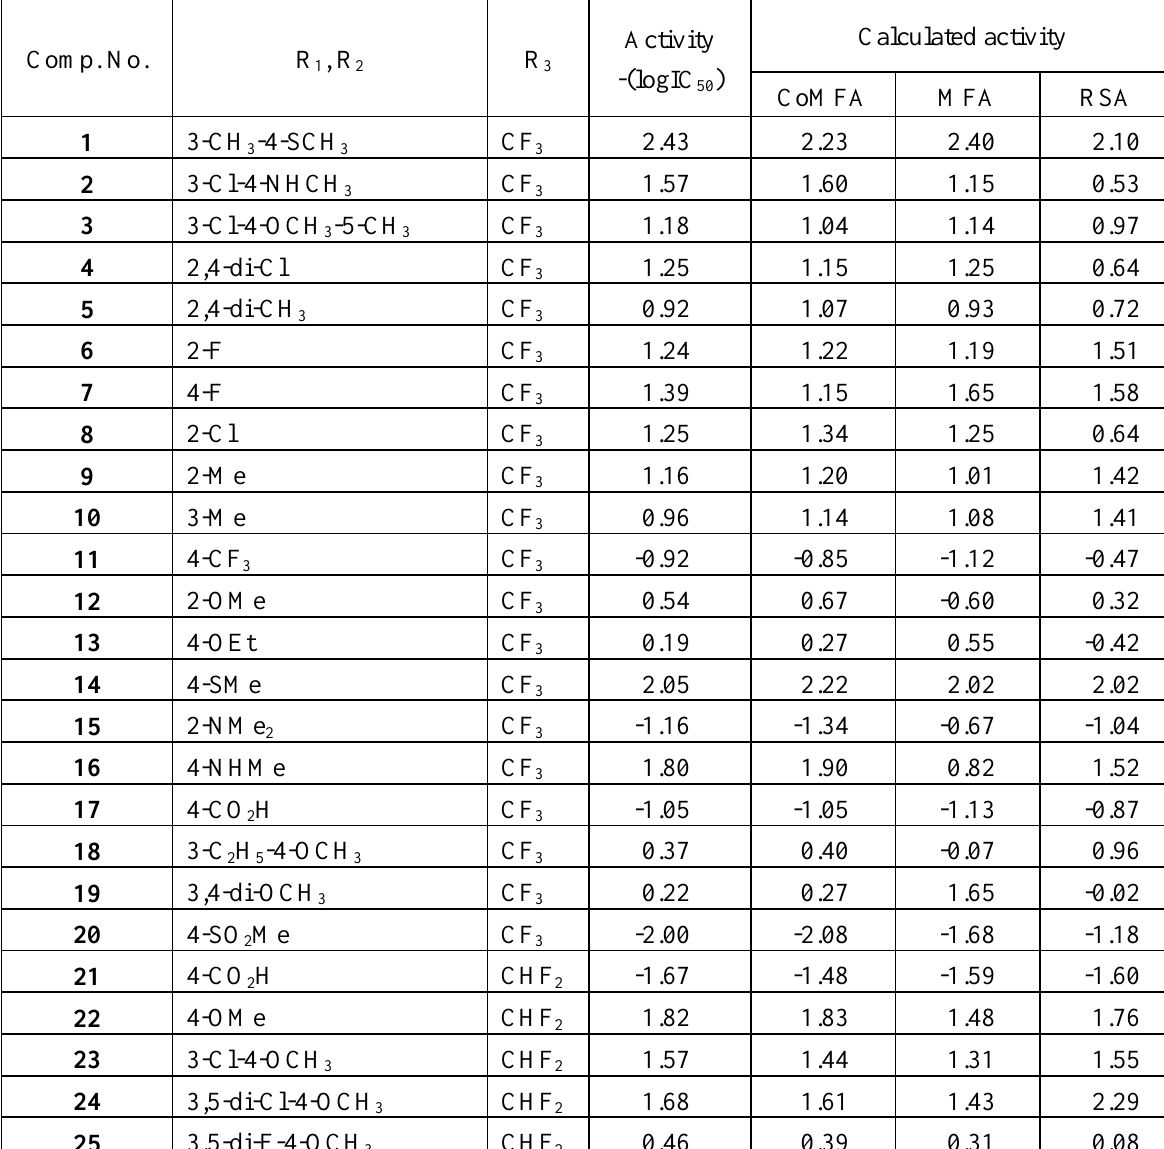
Table 1. Structures, and experimental and calculated inhibitory activities, -(log IC used in the training set based on the molecular skeleton defined in Scheme 1.